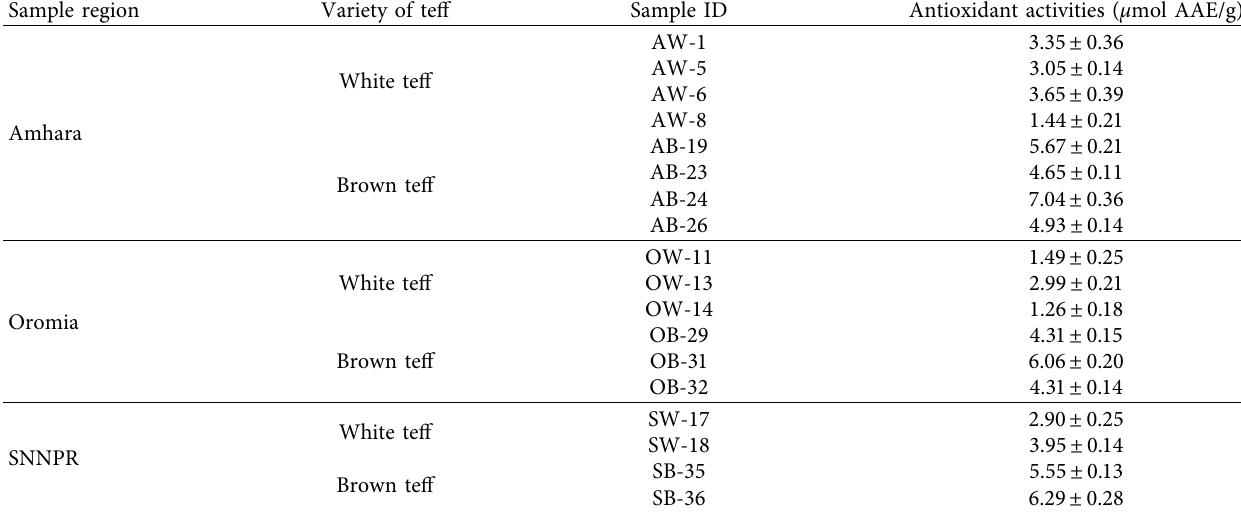
Table 4: DPPH radical scavenging activities in the white and brown tef grains varieties.